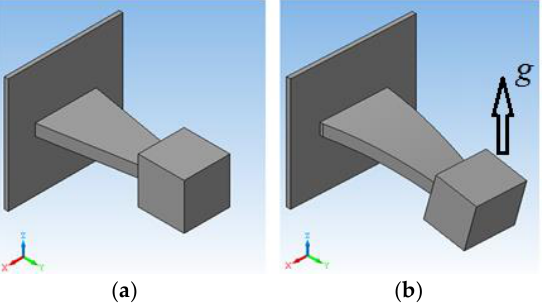
Figure 1. The overall sensitive element design shape ( a ) without external acceleration applied; ( b ) under external acceleration applied.